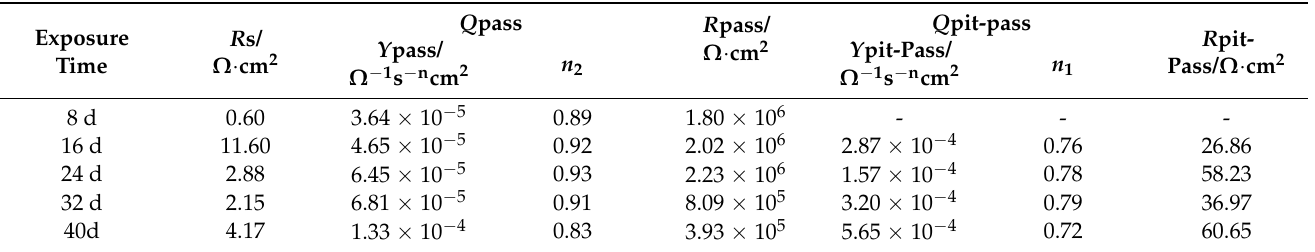
Table 3. EIS fitting data of S32750 SDSS after exposure at different times in the simulated marine